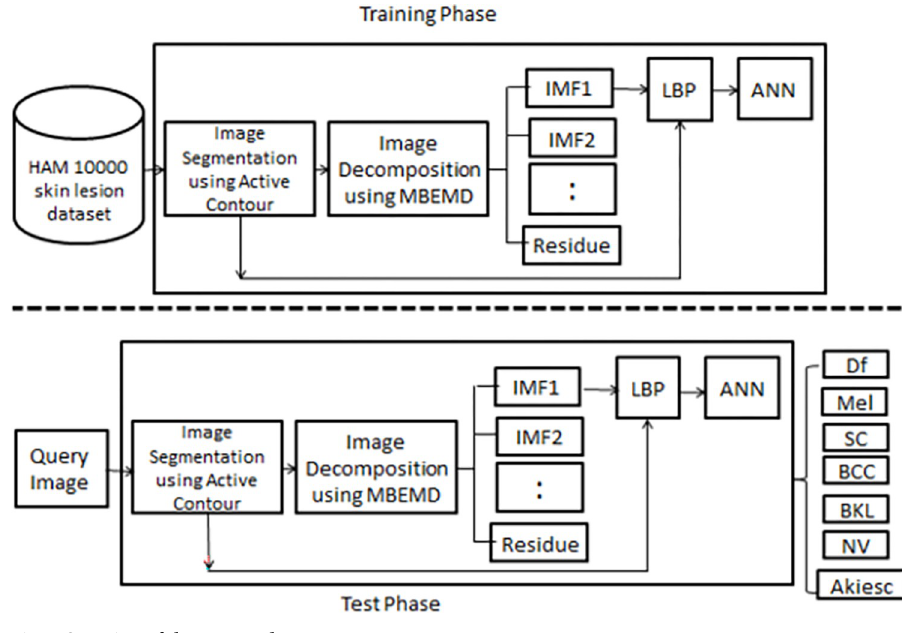
Fig 1. Overview of the proposed